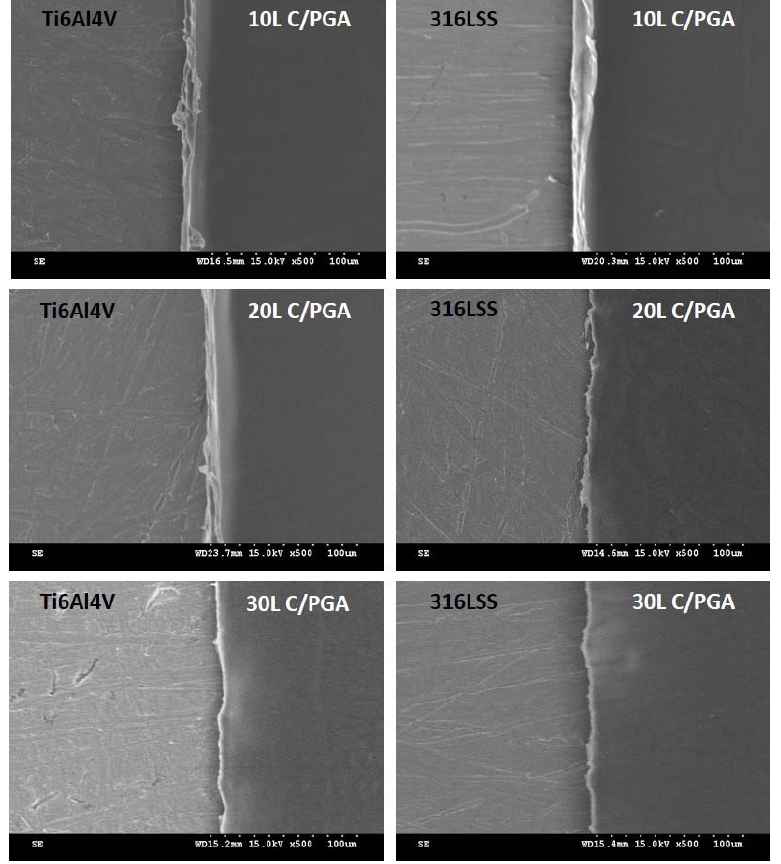
Figure 2. The SEM images of different layers of C/PGA on Ti6Al4V and 316LSS: The images are labelled as nL C/PGA with n indicating 10, 20 and 30 layers of C/PGA PEMs coating.